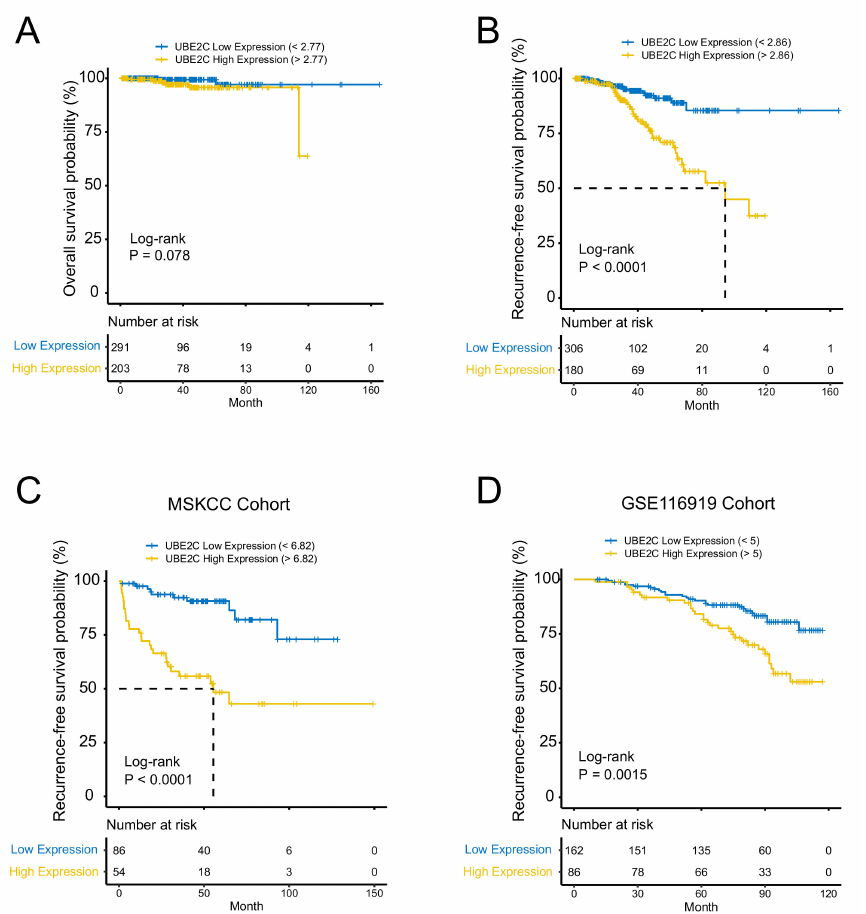
Figure 3. UBE2C is an independent prognostic biomarker in PCa. ( A ) No difference in overall